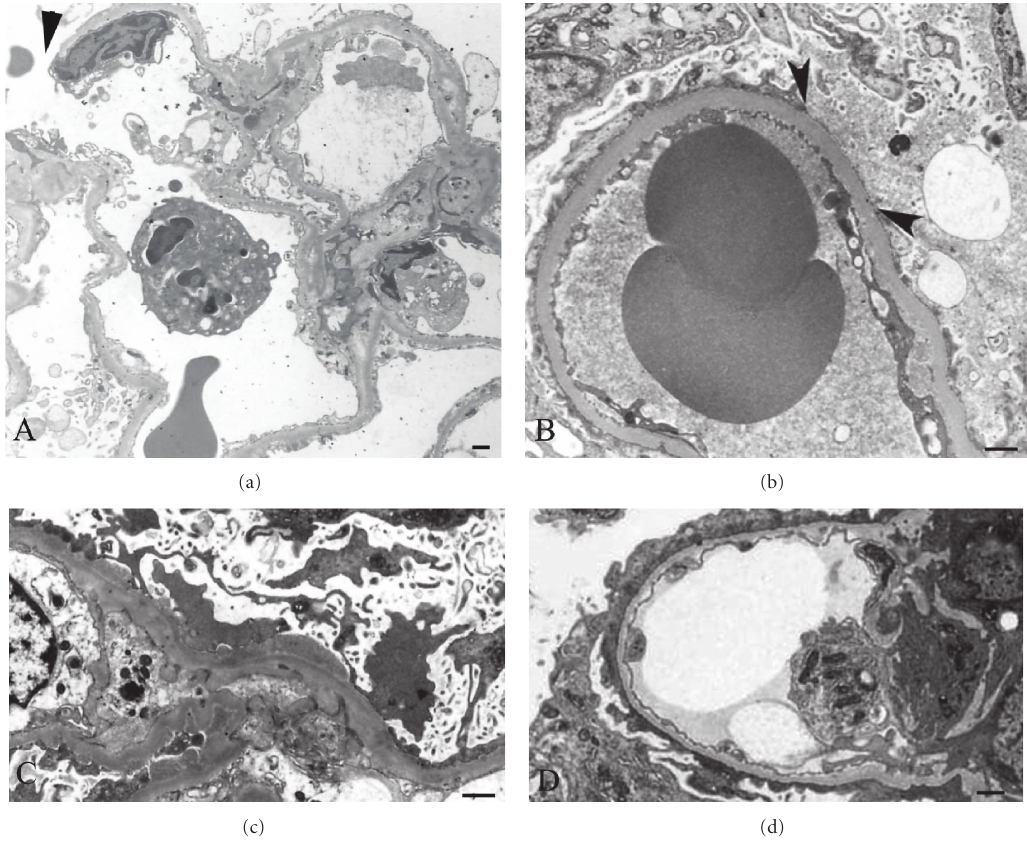
Figure 3: Electron microscopy of human renal biopsy samples. (a) Glomerular basement membrane rupture (arrowhead) in IgA nephropathy. (b) Podocyte loss and a denuded glomerular basement membrane in focal segmental glomerulosclerosis. Proteins were observed as nonuniform electron dense substances in the capillary lumen and also in the urinary space adjacent to the denuded glomerular basement membrane (arrow heads), suggesting large amounts of protein including albumin filtered through the denuded glomerular basement membrane, leading to proteinuria. (c) Podocyte detachment and apoptosis in membranous nephropathy with subepithelial electron dense deposits. (d) Di ff use foot process e ff acement with reduction of the slit membranes in minimal-change nephrotic syndrome. Bars indicate